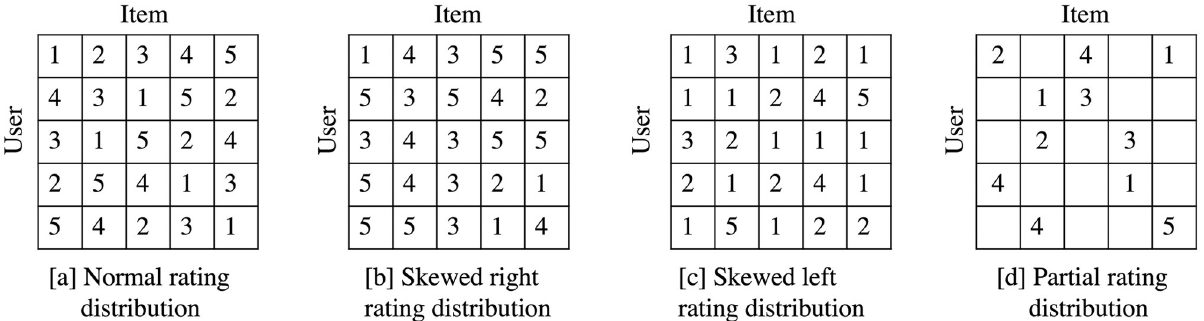
Fig 9. The example of synthetic datasets. [a] Normal rating distribution [b] Skewed right rating distribution. [c] Skewed left rating distribution. [d] Partial rating distribution.